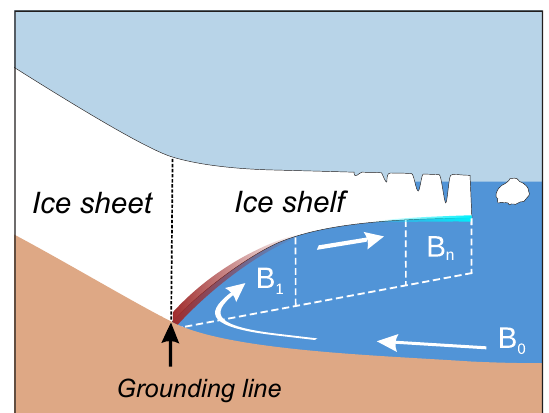
Figure 1. Schematic view of the PICO model. The model mimics the overturning circulation in ice-shelf cavities: ocean water from box B 0 enters the ice-shelf cavity at the depth of the sea floor and is advected to the grounding line box B 1 . Freshwater influx from melting at the ice-shelf base makes the water buoyant, causing it to rise. The cavity is divided into n boxes along the ice-shelf base. Generally, the highest melt rates can be found near the grounding line, with lower melt rates or refreezing towards the calving front.